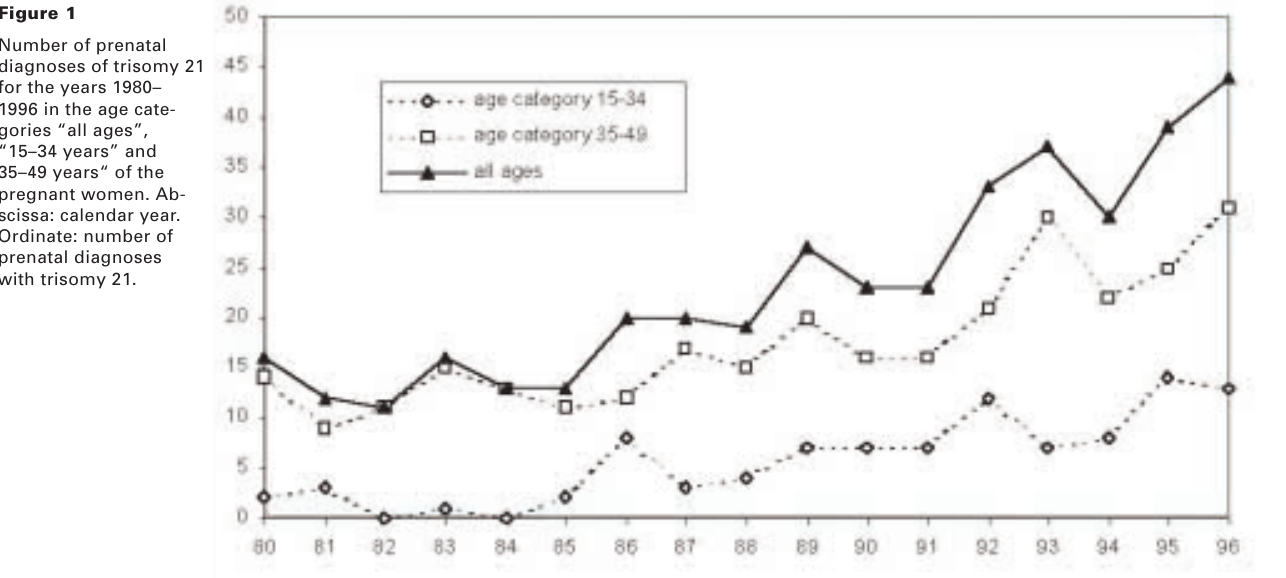
Number of prenatal diagnoses of trisomy 21 for the years 1980– 1996 in the age cate- gories “all ages”, “15–34 years” and 35–49 years“ of the pregnant women. Ab- scissa: calendar year. Ordinate: number of prenatal diagnoses with trisomy